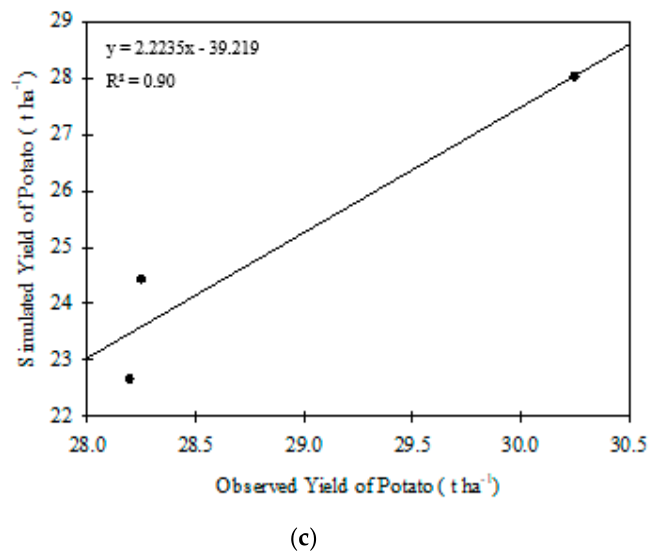
Figure 7. Correlation between observed and simulated for potato yield under 150% ( a ), 100% ( b ), and 50% ( c ) of ETc.